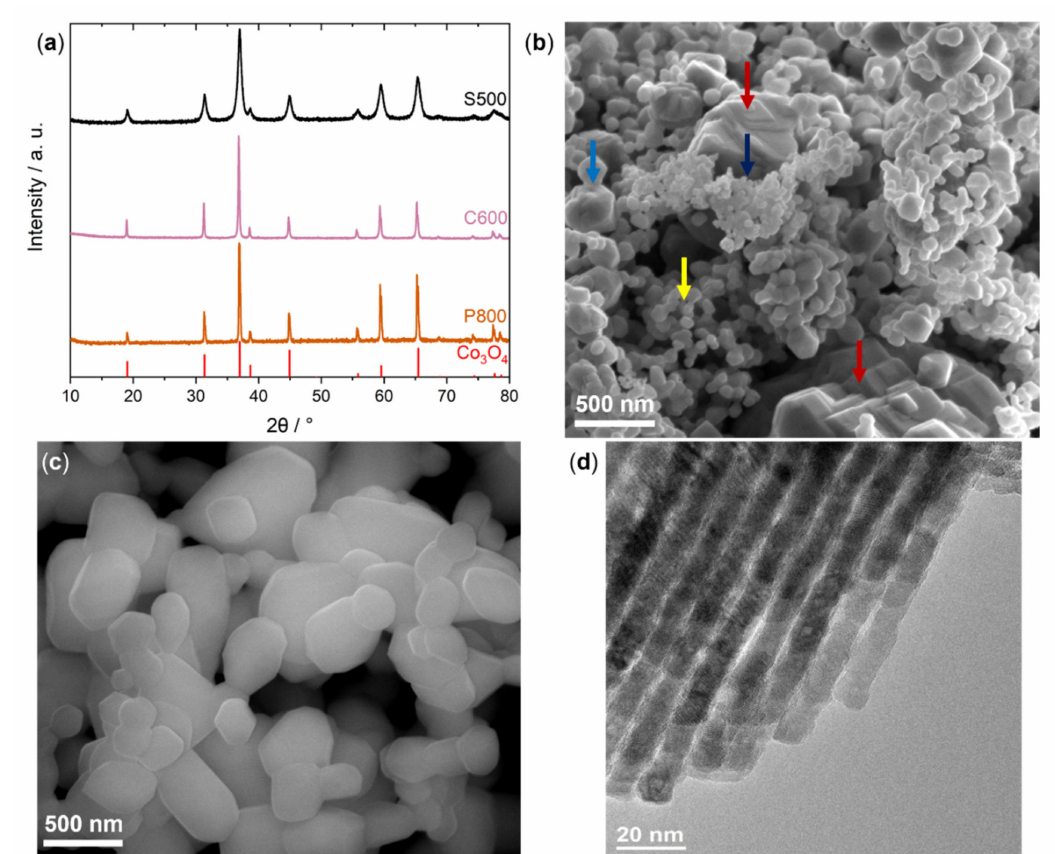
Figure 1. ( a ) XRD patterns of C600, P800, and S500. ( b ) SEM image of C600, different size particles are indicated exemplarily by the use of red (large particles), light blue (medium size), yellow (small), and dark blue (very small) arrows. ( c ) SEM image of P800. ( d ) TEM micrograph of